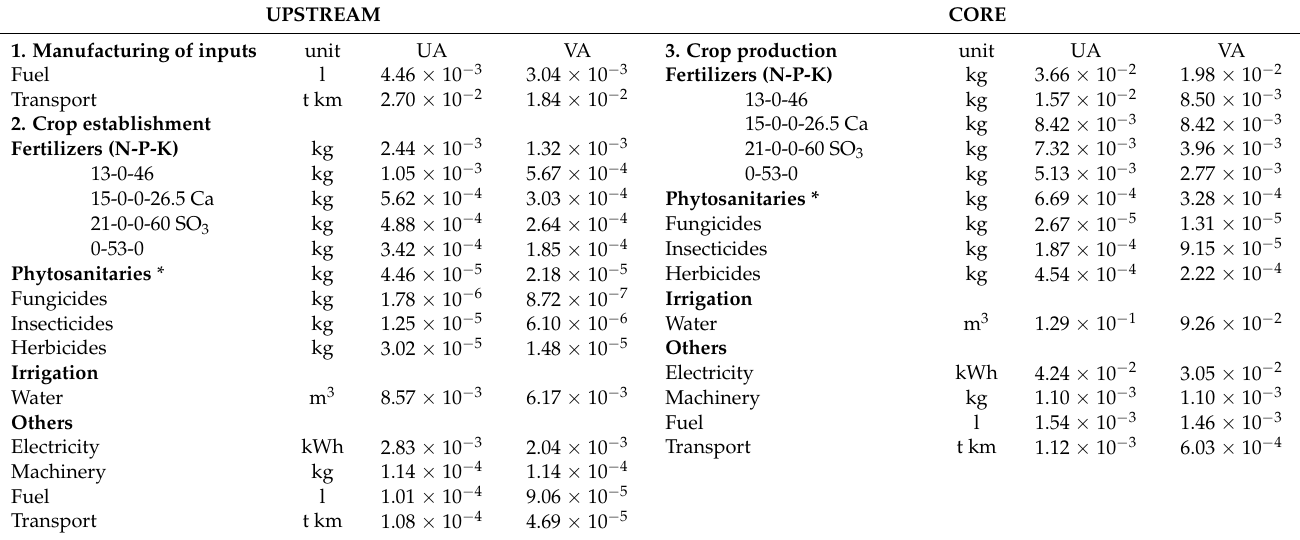
Table 2. Life cycle inventory analysis related to a FU in scenario UA and